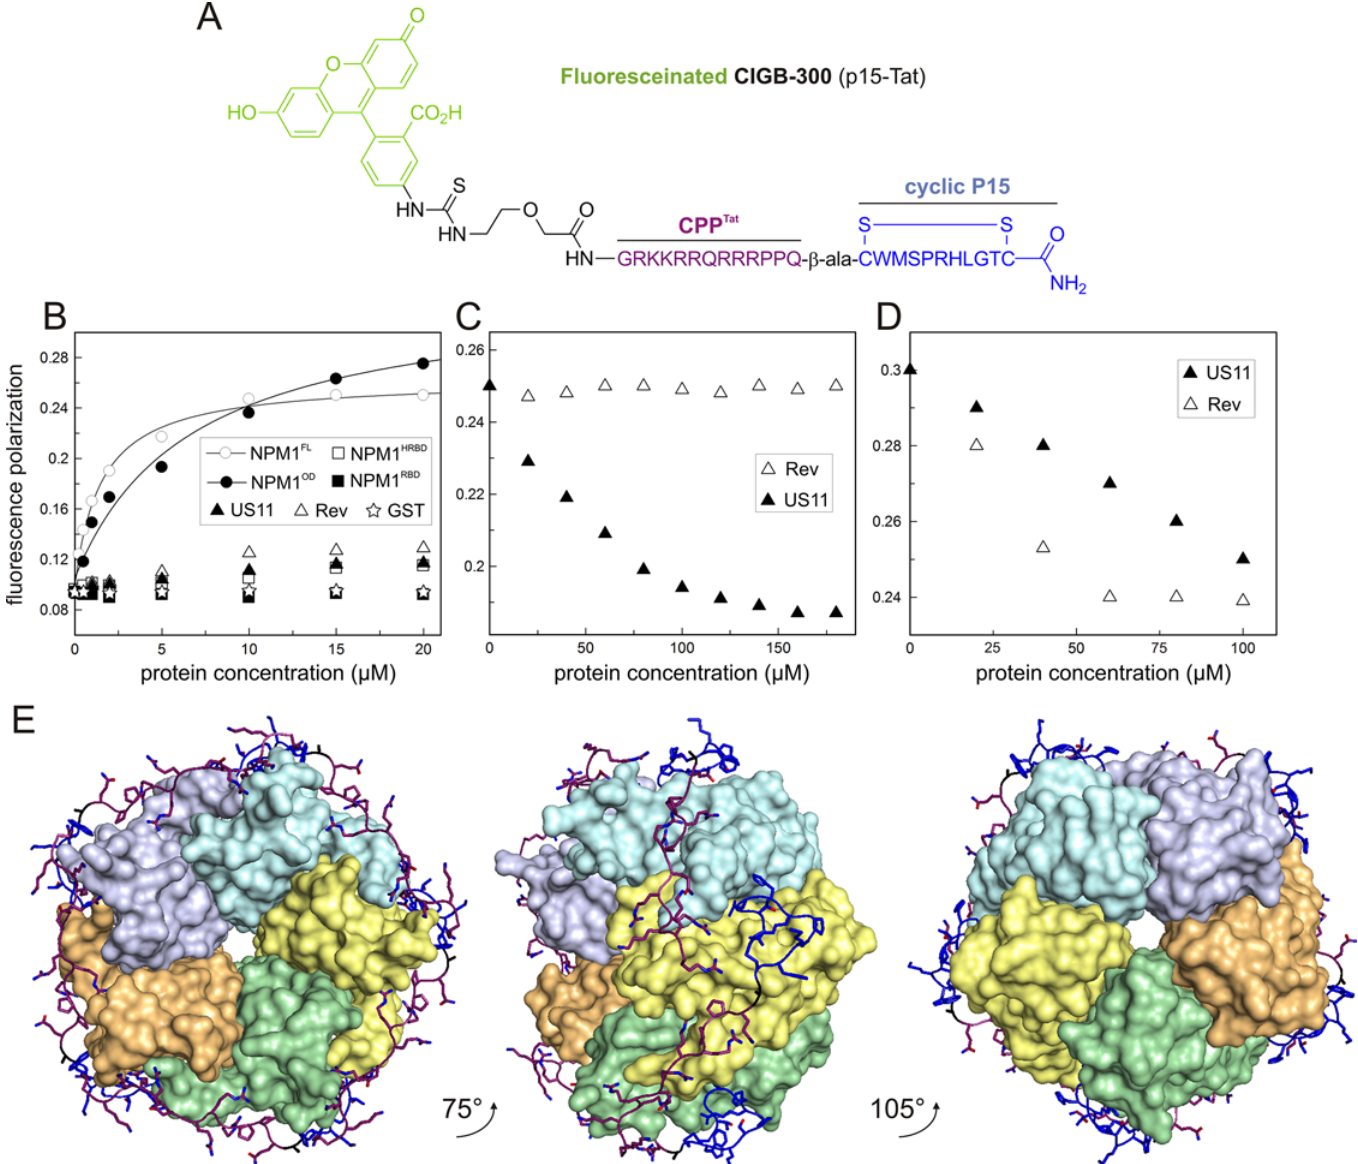
Fig 5. The synthetic peptide CIGB-300 competes with Rev and US11 by binding NPM1 OD with high-affinity. (A) CIGB-300 consists of the cyclic P15 (blue) and the Tat (purple) peptides, and labeled with fluorescein (green; FITC). (B) Fluorescence polarization experiments conducted by titrating increasing amounts of NMP1 variants, Rev, US11, and GST to 0.1 μ M FITC-labelled CIGB-300 (f CIGB-300). A high affinity interaction with the peptide was only observed for NPM1 FL and NPM1 OD , resulting from an increase of polarization, but not for Rev, US11, GST, and the other NPM1 variants. (C-D) Contrary to US11, Rev only displaced NPM1 OD from its fCIGB-300 complex. Displacement experiments were performed by adding increasing amounts of Rev or US11 to the NPM1 FL -fCIGB-300 complex (C) or to the NPM1 OD -fCIGB-300 complex (D). (E) A proposed NPM1 OD -CIGB-300 docking model of pentameric NPM1 OD structure in the complex with CIGB-300. Cyclic part (blue) and basic part (purple) of the peptide shown as sticks and ribbons wraps around several monomeric units of NPM1 represented by surfaces in different colors shown in top view (left), rotated orientation (middle), and the bottom view